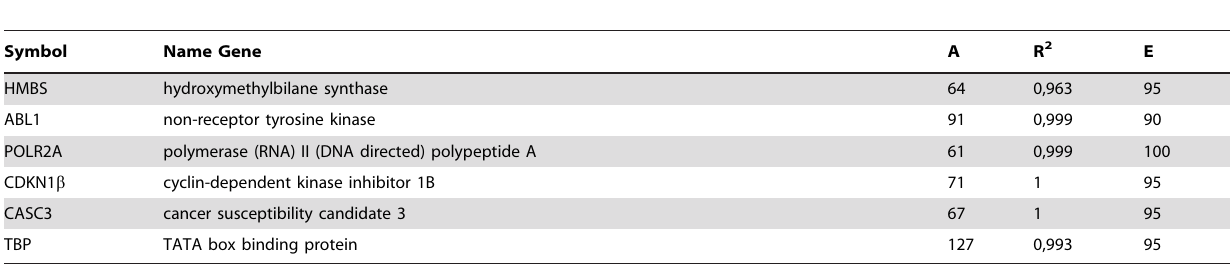
Table 3. Amplicon length (A), correlation coefficient (R 2 ), and amplification efficiencies (E%) of reference genes.